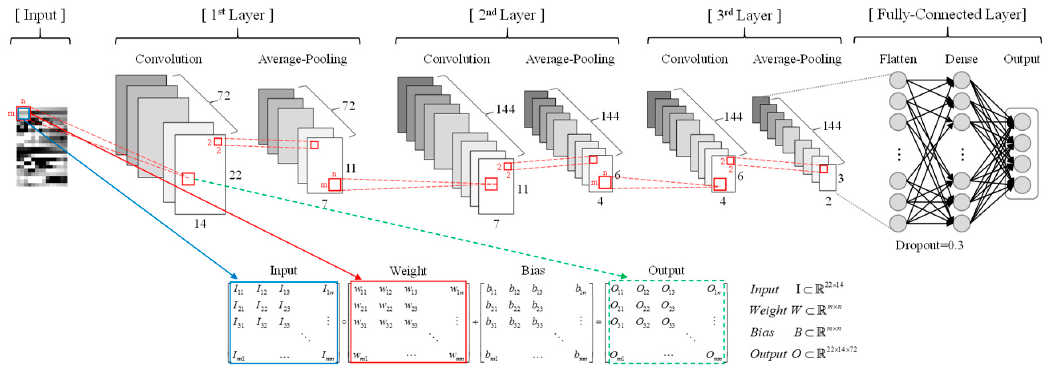
Figure 16. Four label classification CNN architecture.